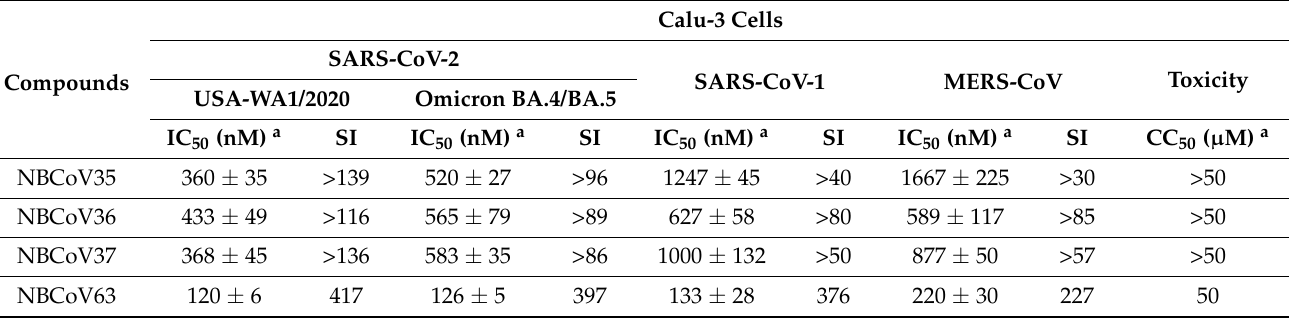
Table 5. Antiviral activity of the NBCoV small molecules in the single-cycle assay in Calu-3 cells against pseudovirus SARS-CoV-2 (USA-WA1/2020) and its VOC Omicron (BA.4/BA.5), SARS-CoV-1, and MERS-CoV, toxicity, and SI.